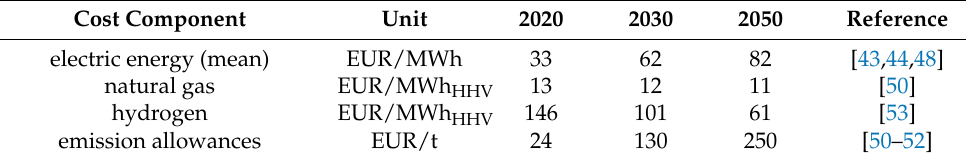
Table 4. Commodity wholesale prices for the years 2020, 2030, and